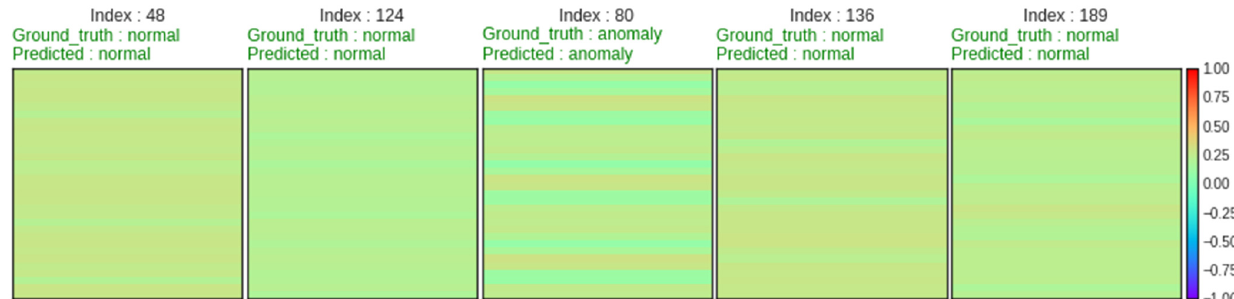
Figure 6. Slide rail data (8 K) Hilbert transform image encoding.